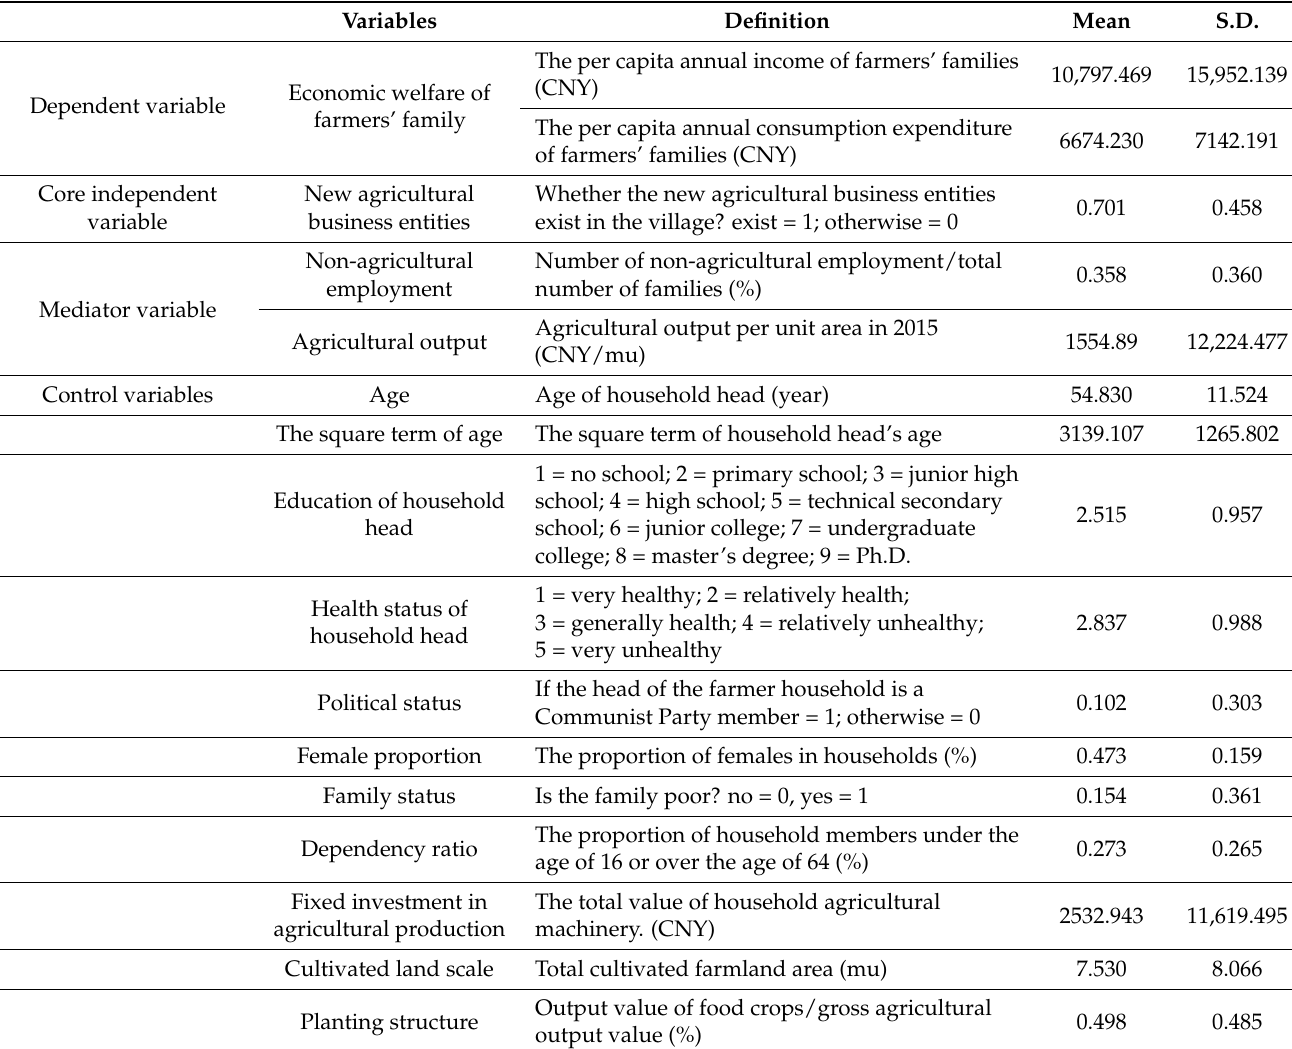
Table 1. Variable definition and summary